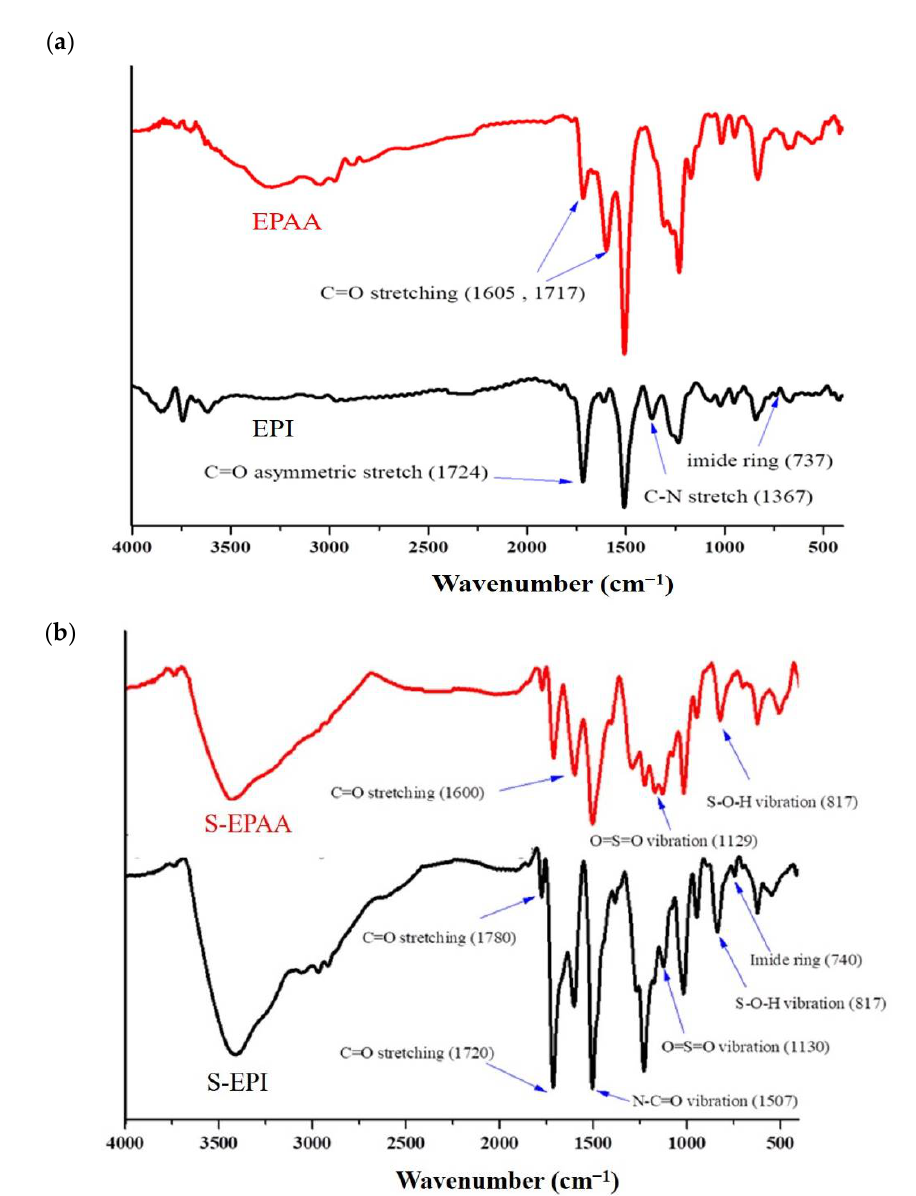
Figure 1. FTIR spectra of ( a ) EPAA and EPI; ( b ) S−EPAA and S−EPI.